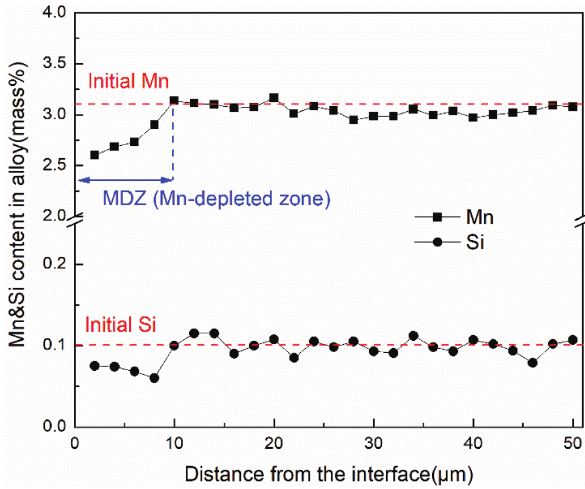
Figure 3: Variation of Mn and Si contents in the alloy away from the interface before heat